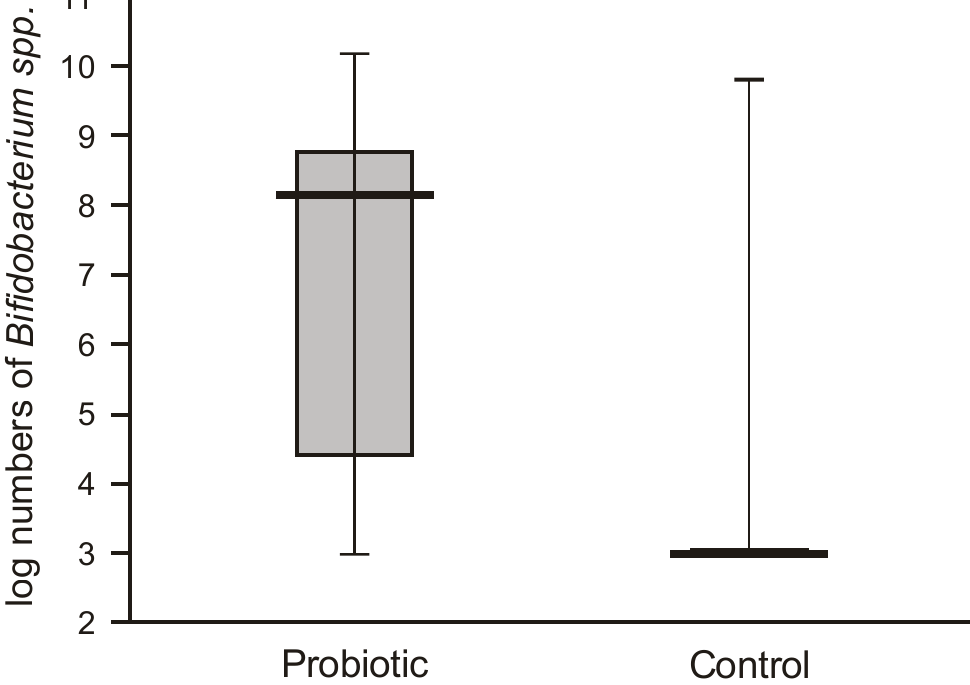
Figure 3. Populations of bifidobacteria in feces obtained from the first sampling of neonates supplemented with probiotics vs. controls (Mann–Whitney test Z = 7.7117; p < 0.00001). High numbers of Lactobacillus (median value of 10 logs/g) remained in the majority of the fecal samples of probiotic-supplemented infants one month after administration. The presence of Lactobacillus was also noted in control infants, with an abundance varying from 4.6 to 7.8 logs/g, but these levels were significantly lower than in the intervention group (Figure 4). The abundance of bifidobacteria in the feces of the supplemented neonates was low in some cases (median value of below 8 logs/g), thereby resulting in a similar median value to that of the control infants (6.7 logs/g), with no significant difference between these groups (Figure 5).